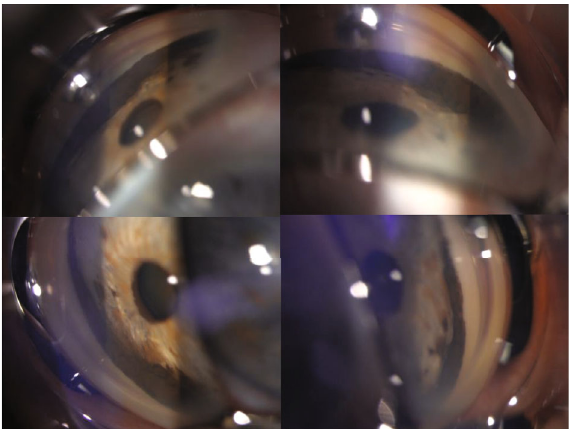
Figure 2: Gonioscopy showed a circumferential pigmented angle in fi ltration.